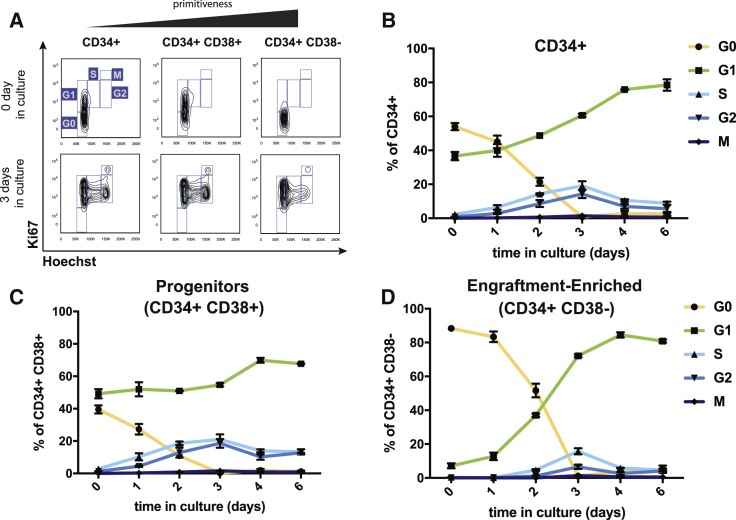
Cell Cycle Progression of Human mPB CD34+ Cells in Ex Vivo Culture(A) Representative flow cytometry plots for assessing cell cycle status in CD34+, CD34+ CD38+ (progenitors), and CD34+ CD38− (EE) populations. CD34+ cells were stained with antibodies against Ki67 and Hoechst 33342. G0: 2N DNA and Ki67 negative, G1: 2N DNA and Ki67 positive, S/G2/M: 4N DNA and Ki67 positive.(B) Cell cycle status of CD34+ cells in ex vivo culture. Notably, ∼60% of bulk CD34+ cells are in G0 at day 0, and 100% of the cells are cycling by day 3.(C) Cell cycle status of CD34+38+ progenitor cells in ex vivo culture. More than 50% of progenitor cells are cycling at day 0, and the percentage of cycling cells continually increase until day 3.(D) Cell cycle status of CD34+38− EE HSPCs in ex vivo culture. Notably, ∼90% of the EE HSPCs are quiescent at day 0, and EE HSPCs gradually exit quiescence until day 3 where 100% of them are cycling.Representative data from experiments performed with three different mPB donors and n = 2 biological replicates per donor.See also Figure S2.